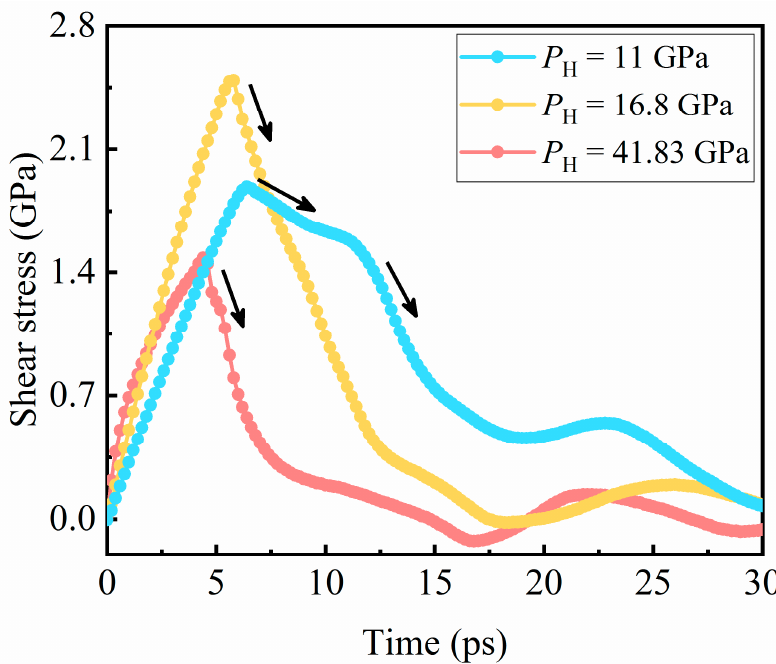
Figure 4. Evolution of shear stress with time on release for different Hugoniot states.